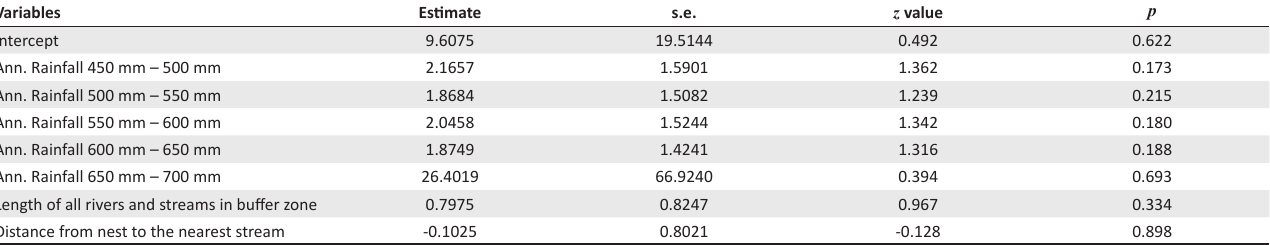
TABLE 4: Parameter estimates, standard errors, z values, p -values and adjusted p -values (using False Discovery Rate) for variables in the best WATER model for Southern Ground-hornbill nesting success (with the lowest Akaike information criteria).